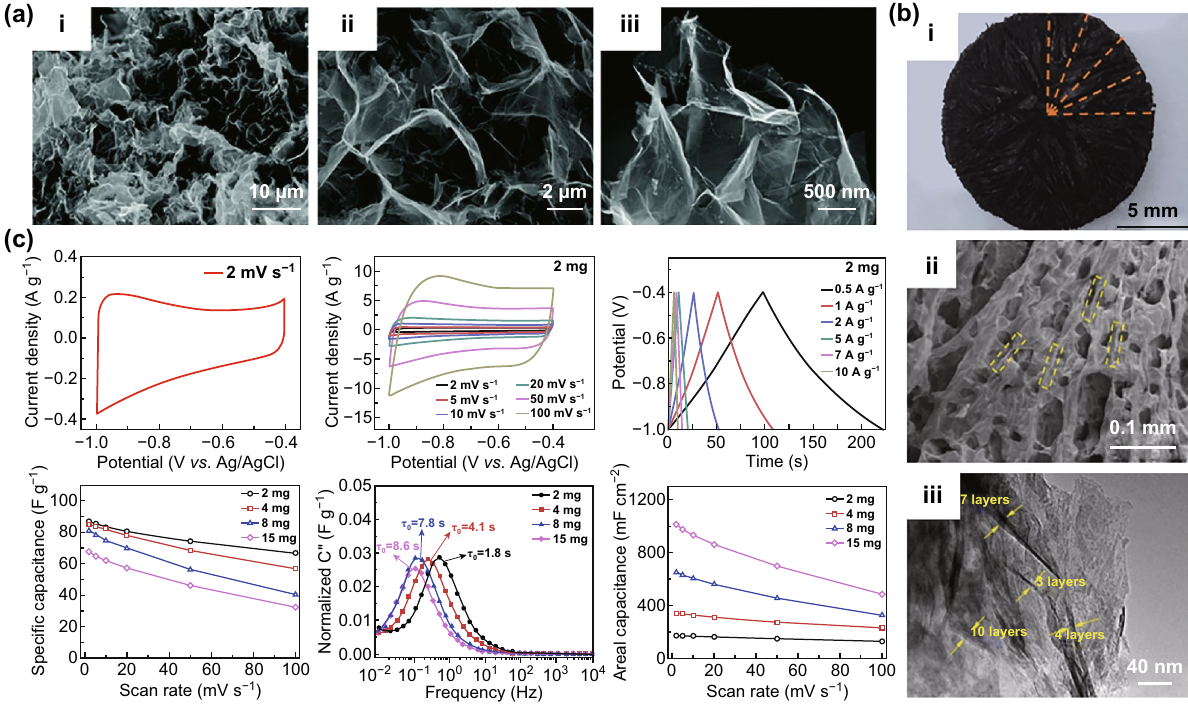
Fig. 6 Ti 3 C 2 T x aerogel. a SEM image of the Ti 3 C 2 T x aerogel with different magnifications [40]. b Cross-sectional view of Ti 3 C 2 aerogel, SEM image of Ti 3 C 2 aerogel, and TEM of void walls. c CV and GCD curves of Ti 3 C 2 aerogel, specific capacitance with different mass loadings, progression of the imaginary (C ″ ) parts of the stack capacitance of Ti 3 C 2 aerogel and areal capacitance with different mass loadings [96]. Repro- duced with permission from Refs. [40,